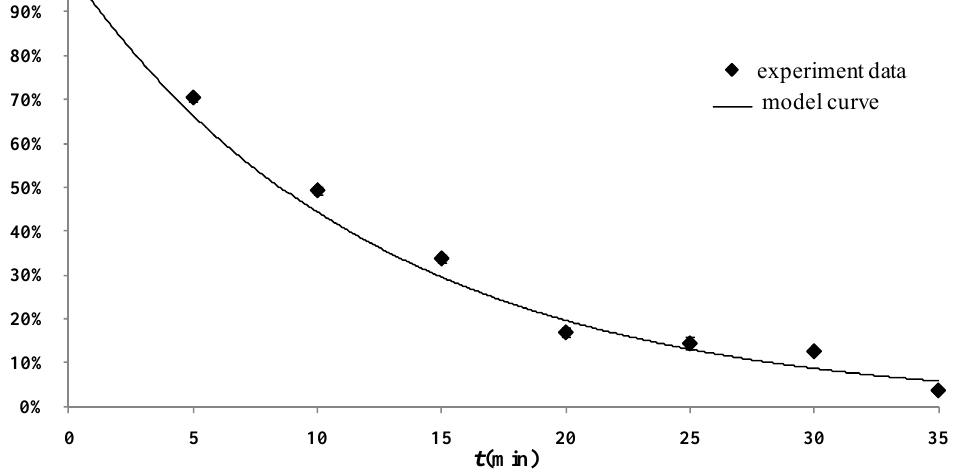
= 50 mg/L, C = 600 mg/L, S = 500 W/m) 0 t L